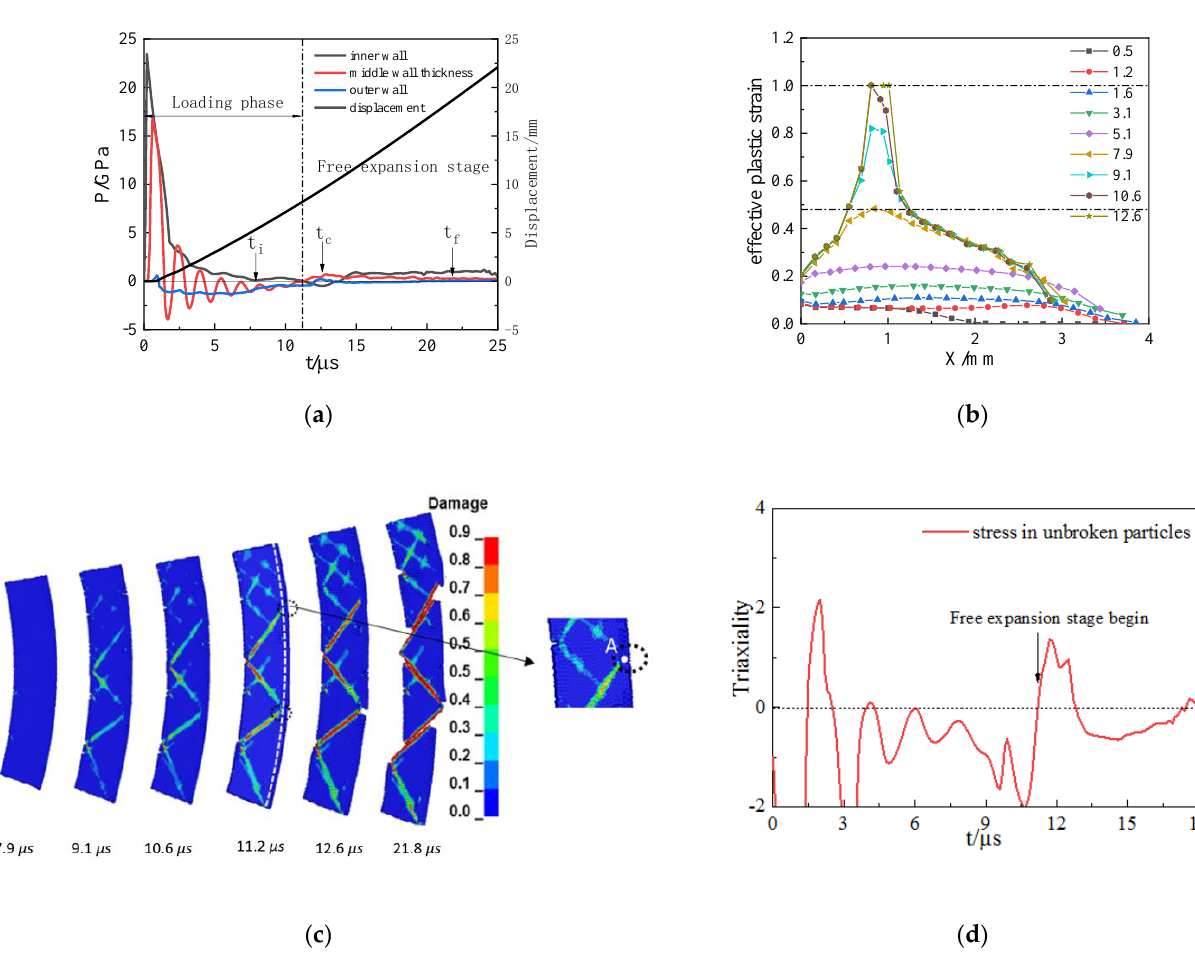
Figure 11. The explosive pressure, expanding deformation, and fracture for 45 steel cylinder shell under TNT loading: ( a ) detonation wave propagation curves; ( b ) development of effective plastic strain in the shell thickness; ( c ) damage evolution for fracture; ( d ) triaxial stress. Under the loading of HNS with low detonation pressure, the 45 steel shell also undergoes tensile – shear mixed fracture, but tensile cracks accounted for a higher proportion in the fracture, about one-half. Shear cracks are less developed because fracture development takes less time during the loading phase, as shown in Figure 12.